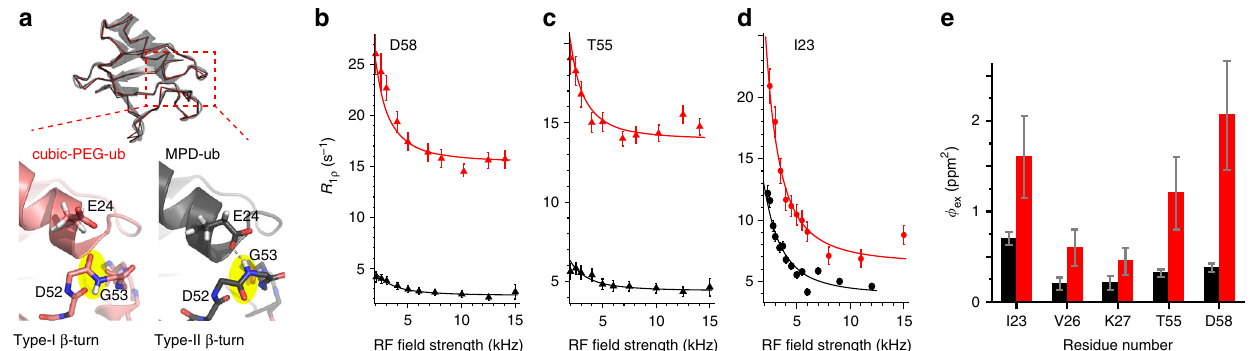
Fig. 1 Evidence for β -turn exchange in MPD-ub ( black ) and cubic-PEG-ub ( red ) crystals. a Structures of ubiquitin in the two crystal forms. Top : superposition of the main chains in the two crystals, shown as C α backbone traces; for cubic-PEG-ub only one of the two non-equivalent chains is shown. For clarity, the semi-transparent cartoon representation is shown only for MPD-ub. Bottom : zoom into the β -turn region. The peptide bond undergoing a fl ip is highlighted in yellow. b – d BMCRD pro fi les of 15 N sites in the two ubiquitin crystal forms, obtained at a sample temperature of 300 K. Data shown here for D58 and T55 were obtained at B 0 fi eld strengths corresponding to 1 H Larmor frequencies of 600 MHz, and those of I23 at 950 MHz, respectively. Error bars of R 1 ρ values were obtained by standard Monte Carlo analyses, described in the Methods section. Solid lines correspond to a global two-site exchange model fi t of data from residues I23, V26, K27, T55, D58 within each of the crystal forms ( solid lines ). The fi ts were performed separately for each of the two crystal forms using in each case the same cluster of the aforementioned fi ve residues. Note that the resonances of E24 and N25 are not visible, presumably as a consequence of the conformational exchange. The comprehensive set of BMCRD data and fi tting results can be found in Supplementary ¼ p π Δ δ ð Þ 2 in cubic-PEG-ub ( red ) and MPD-ub ( black ), obtained from the joint fi t of residues I23, V26, K27, T55, and Figs. 2, 3, and 5. e ϕ ex values, ϕ A p B 2 ex D58, exempli fi ed by curves in b – d . Here p A and p B are the populations of the two conformers, while Δ δ is the chemical shift difference expressed in the units of ppm. Fitted exchange time constants are reported in Table